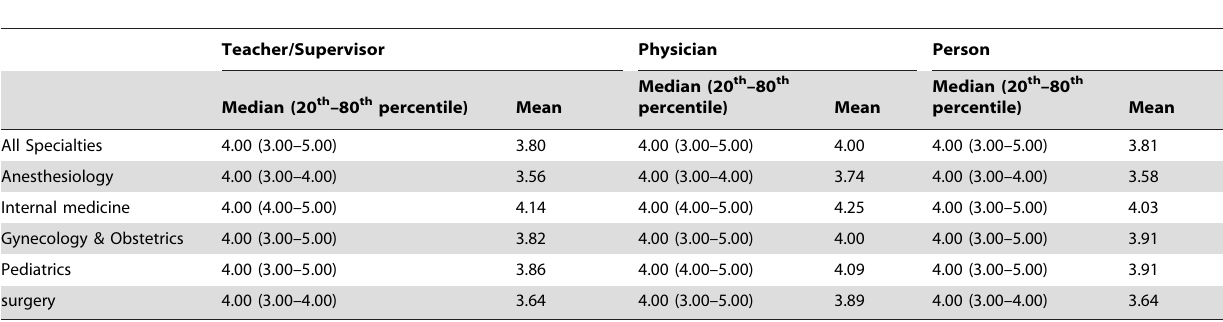
Table 2. Median and mean score of residents’ ratings of the items: During my residency, this faculty is a role model to me in his/ her role as… [1: teacher/supervisor, 2: physician and 3: person].